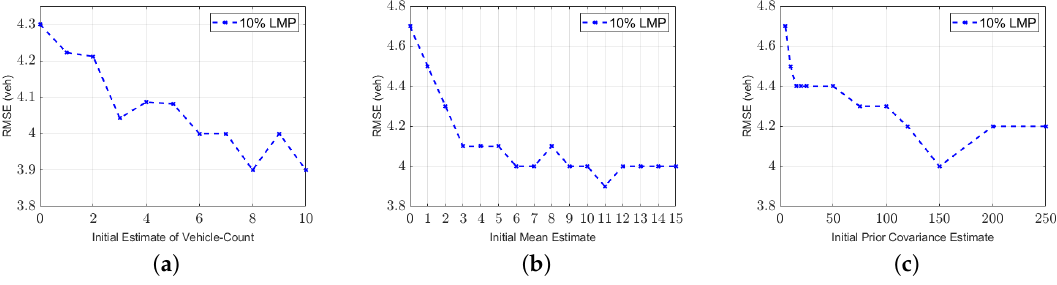
Figure 6. Impact of the initial conditions on the AKF model: ( a ) Initial estimate values N i , ( b ) Initial mean estimate values m i , and ( c ) Initial covariance estimate values P i .